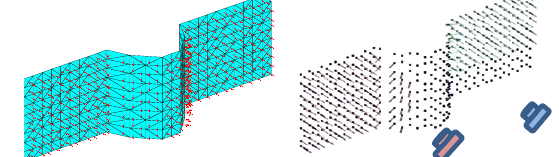
Figure 3. Visibility by using the triangular surface normal